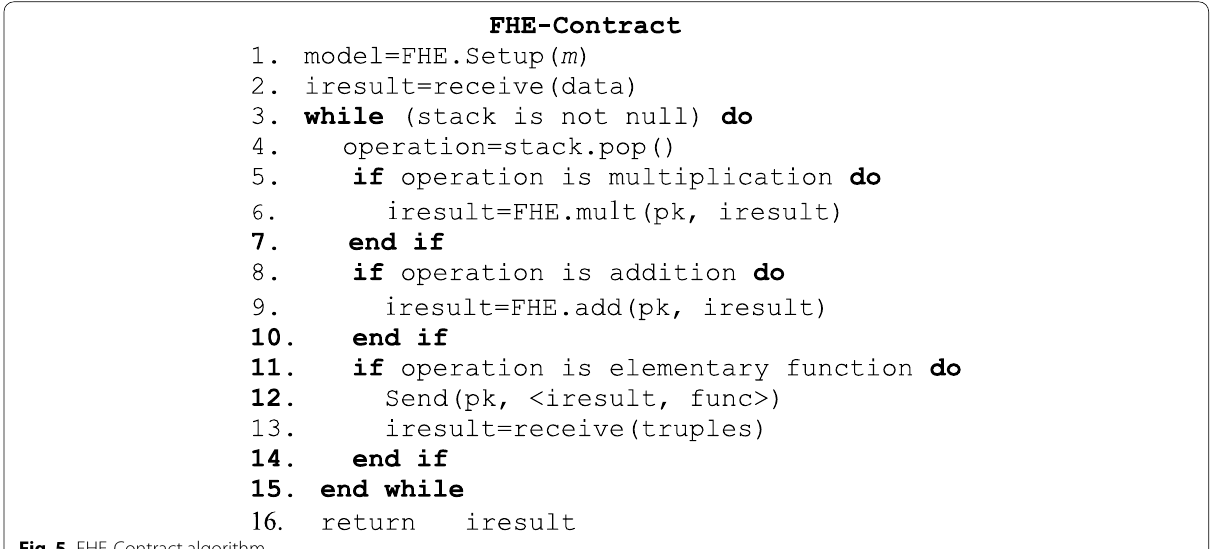
Fig. 5 FHE-Contract